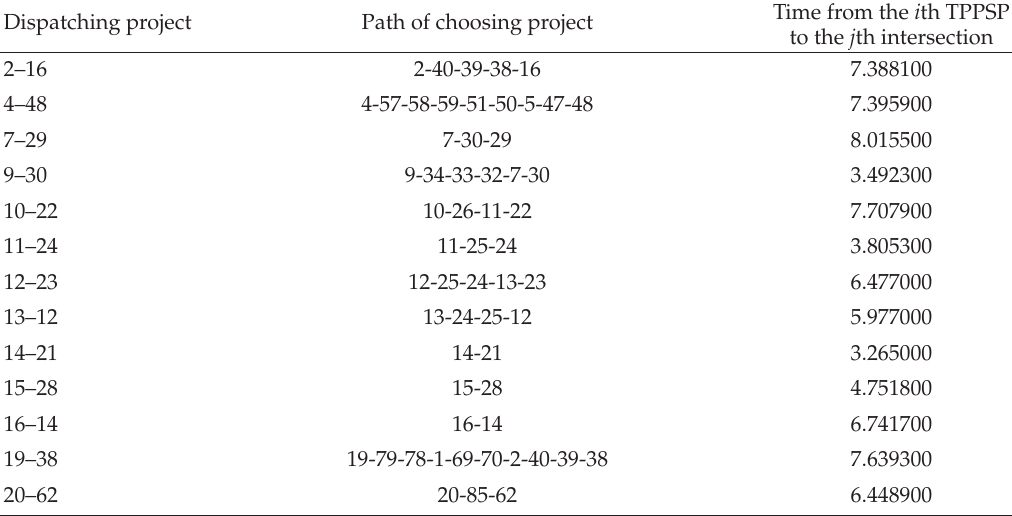
Table 5: The optimal dispatch project of TPPSP with T pq (cid:8)